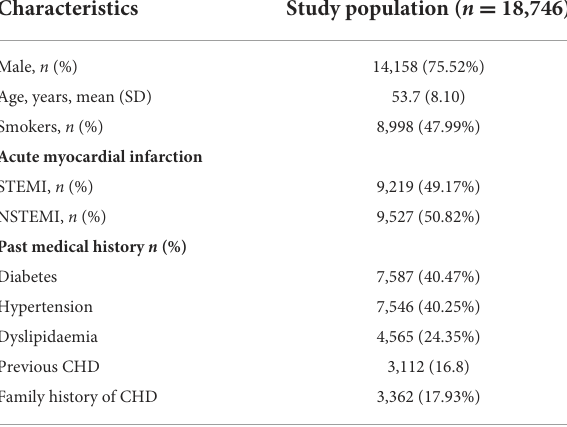
TABLE 3 The association between demographic parameters and risk factors in the studied population diagnosed with AMI.